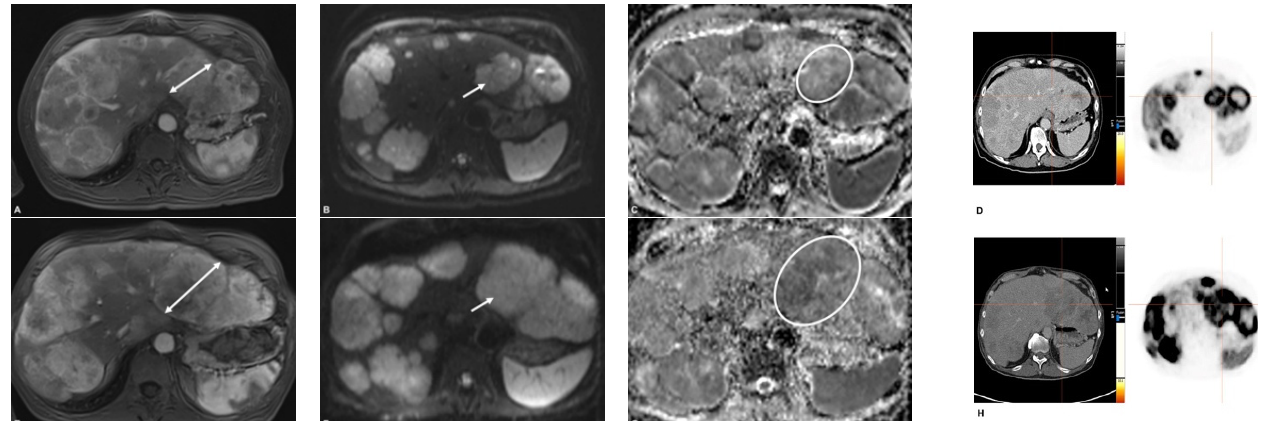
Figure 2. Patient with progressive disease. On arterial phase, lesion in the left lobe showed strong arterial enhancement ( A ) with diffusion restriction on diffusion-weighted image with b = 800 mm²/s ( B ) and low signal on ADC map ( C ). On PET/CT the lesion showed an SSR-overexpression ( D ). After TARE, there was a significant increase in size of this lesion with remaining arterial enhancement ( E ), restricted diffusion ( F ), low ADC signal ( G ), and increasing SSR overexpression ( H ). This lesion was rated as progressive disease.